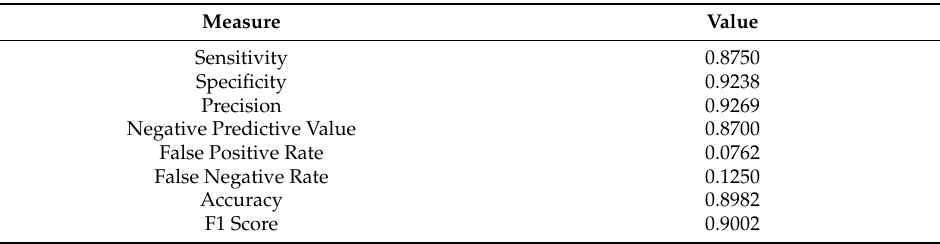
Table 6. SVM Confusion Matrix Measure Values.